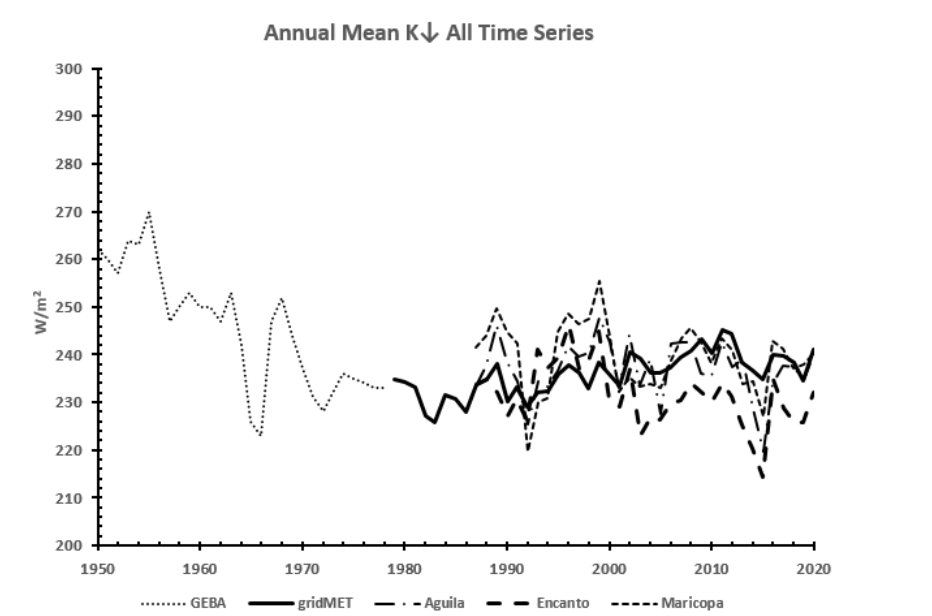
Figure 4. Annual trend GEBA, gridMET; Aguila, Encanto, Maricopa. Table 8. Linear regression K ↓ ANNUAL = A*(year) + B with bootstrapping (N=1000). Time series defined in Table 7. Table 7. Descriptive statistics of annual data with bootstrapping (N = 1000). *CI = confidence inter-